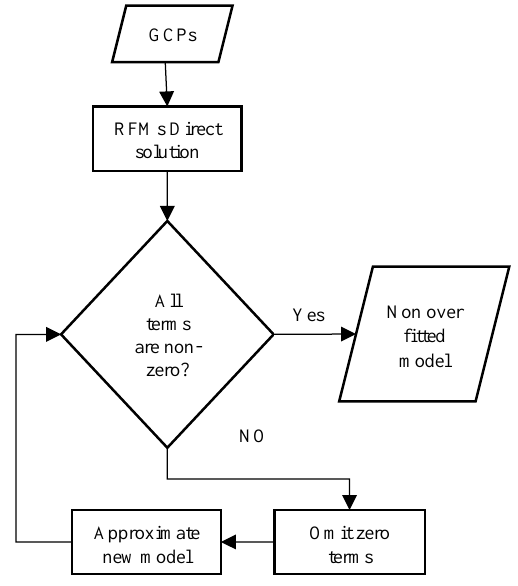
Figure 1. Flow chart of the proposed method